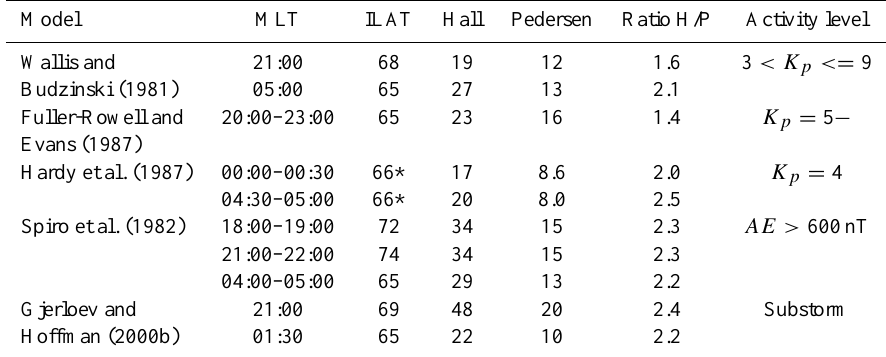
Gjerloev and 21:00